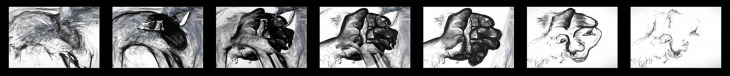
Exemplary frames of the stop-motion movie Konstrukte by Claudia Muth (from the year 2009). Image courtesy of Claudia Muth.